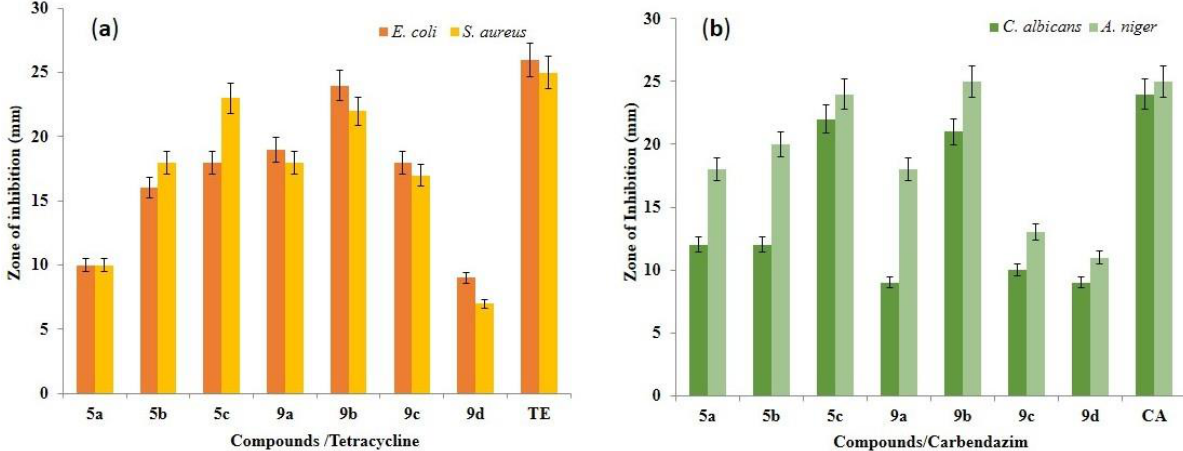
Figure 6. Antimicrobial efficiency of compounds 5a – c and 9a – d . ( a ) Zone of inhibition of tested bacteria, i.e., E. coli MTCC 25922 and S. aureus MTCC 25923. ( b ) Zone of inhibition of tested fungi, i.e., C. albicans MTCC 282 and A. niger MTCC 227. Results are expressed as mean ± SD for n = 3. Bars with the same letter are not significantly different at p > 0.05.